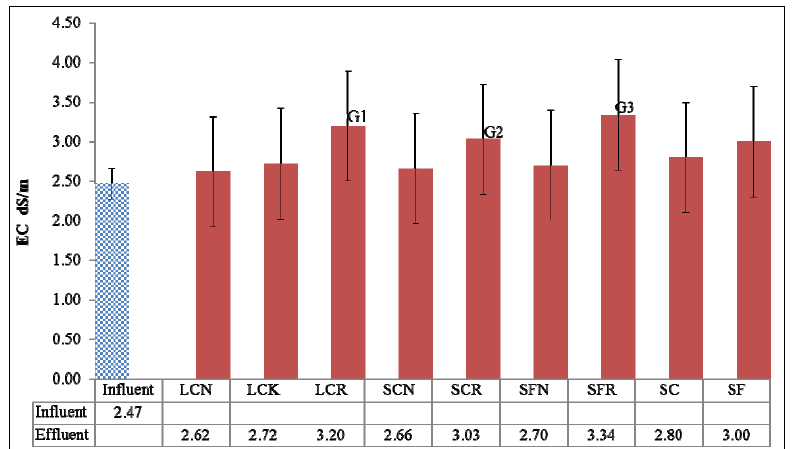
Figure 3. The mean electrical conductivity (EC) in influent and effluent of various treatments. (1) EC in all the effluents were significantly ( p < 0.05) higher than the influent. (2) G1: significant differences ( p < 0.05) among (LCN, LCK and LCR) effluents; G2: significant differences ( p < 0.05) between (SCR and SCN) effluents; G3: significant differences ( p < 0.05) between (SFN and SFR) effluents. (3) Abbreviation